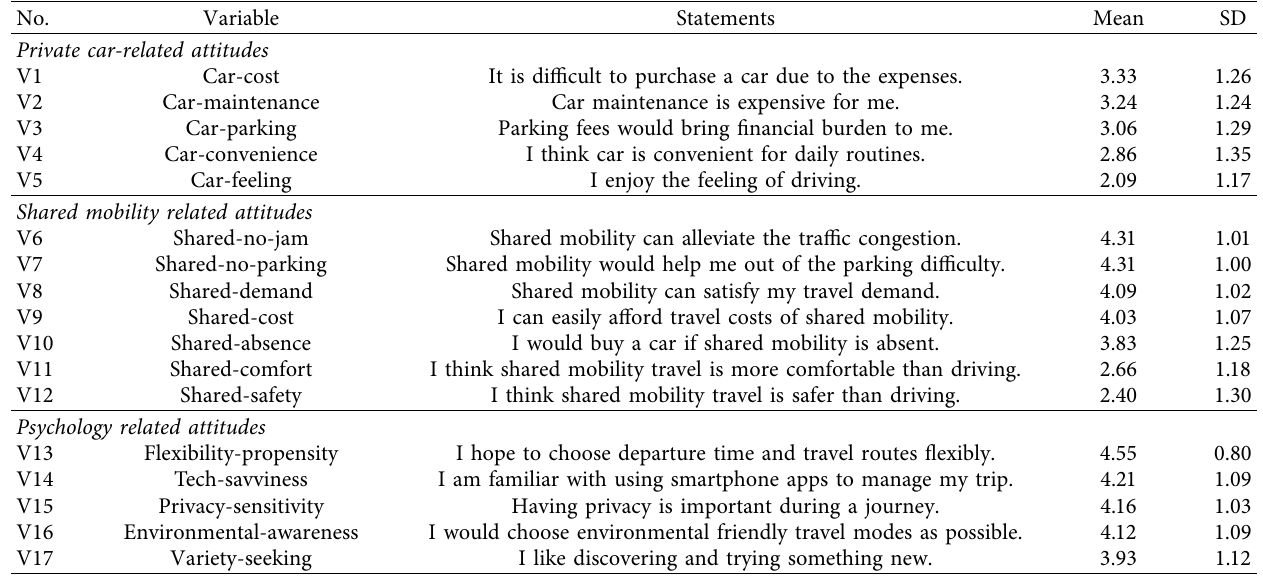
Table 2: Attitudinal statements and their